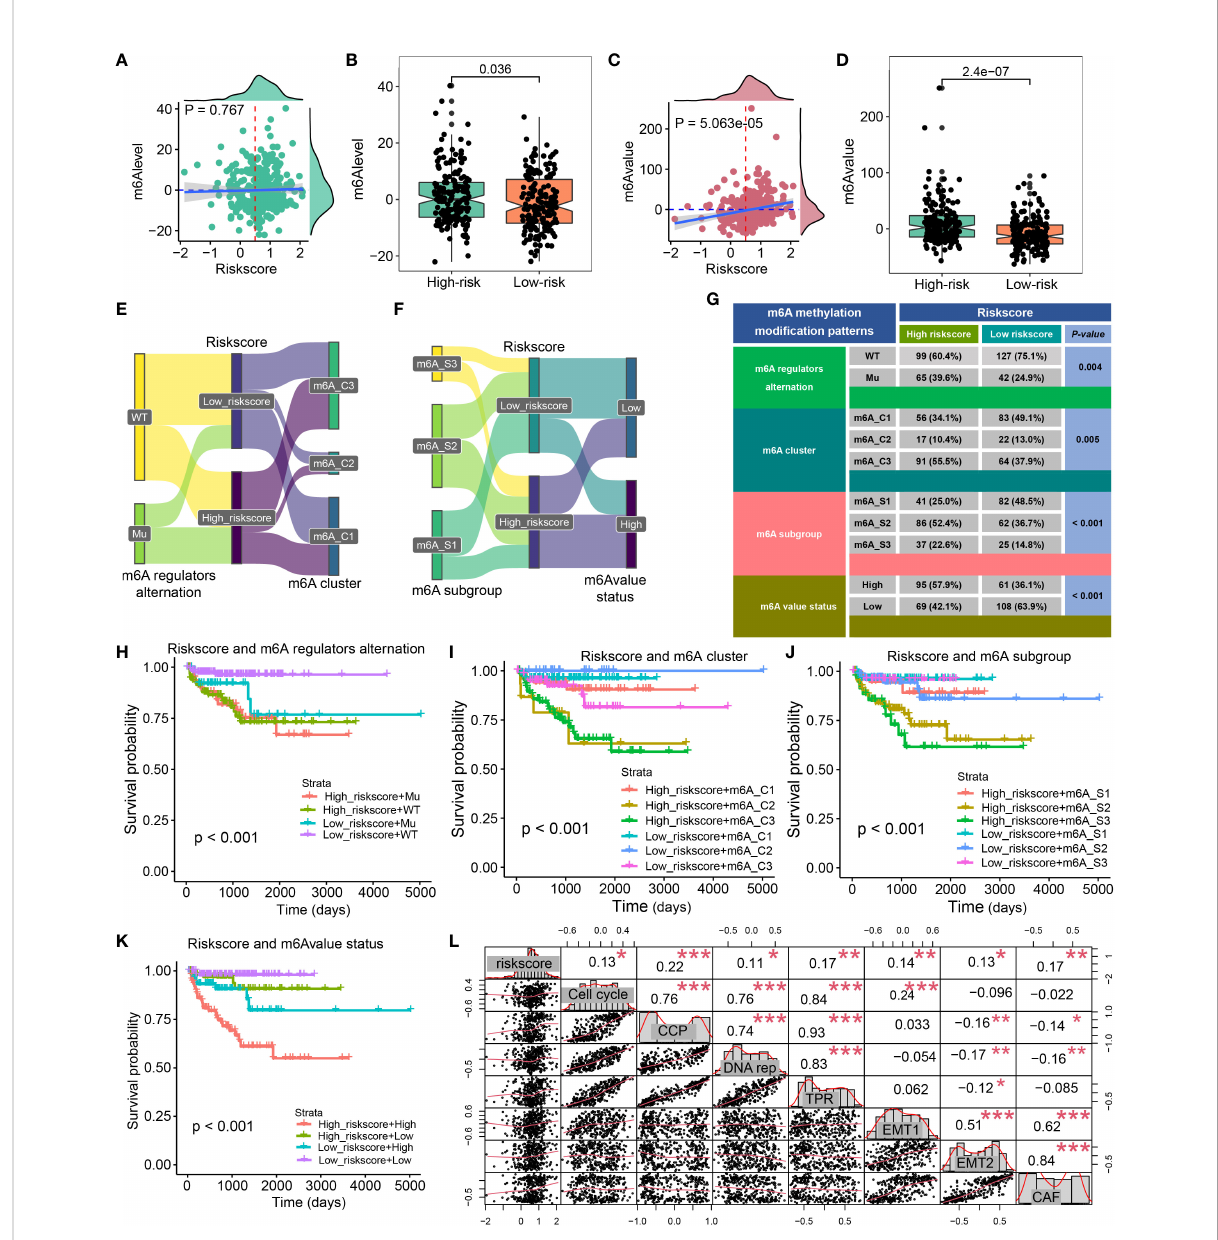
FIGURE 8 Association between CRPGS and m6A status. The association between riskscore and m6Alevel and m6Avalue (A – D) . Sanky plot showed the comparison results of CRPGS with m6A regulators alteration, m6A cluster, m6A subgroup, m6A value status (E – F) , and the c 2 test table showed the distribution of CRPGS in different m6A regulators alteration, m6A cluster, m6A subgroup, m6A value status groups (G) , and the combined effects of CRPGS + m6A regulators alteration/m6A cluster/m6A subgroup/m6A value status on PCa patients ’ survival (H – K) . The correlation plot showed the association between CRPGS and other seven tumor signatures (Cell cycle, Cell cycle progression, DNA replication, Tumor Proliferation Rate, EMT1, EMT2, Cancer-associated fi broblasts) (L) . CAF, Cancer-associated fi broblasts; CCP, Cell cycle progression; DNA rep, DNA replication; EMT1, Epithelial-mesenchymal transition; TPR, Tumor Proliferation Rate. *p < 0.05; **p < 0.01; ***p <